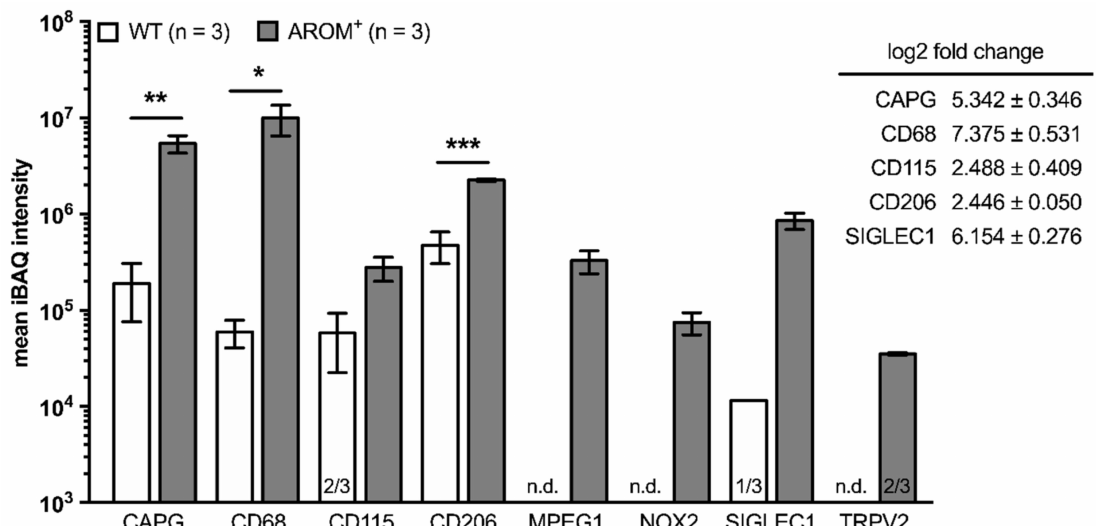
Figure 3. Mass spectrometry-based comparison of expression profiles in old WT and AROM + testes. Extracted proteins from testicular tissue of 11 month-old WT and AROM + animals ( n = 3, each) were subjected to mass spectrometry. The graph presents iBAQ intensities (mean ± SEM) of detected proteins and results of statistical analysis of a genotype-dependent comparison when proteins could be detected in all replicates using an unpaired two-tailed t -test with α = 0.05; * p ≤ 0.05, ** p ≤ 0.01, *** p ≤ 0.001. The numbers of positive replicates other than 3/3 are depicted at the bottom of each column (n.d.: not detected). The insert on the right depicts the mean differential expression of detected proteins (log2 fold change) in testes from AROM + animals compared to coeval WT animals, if